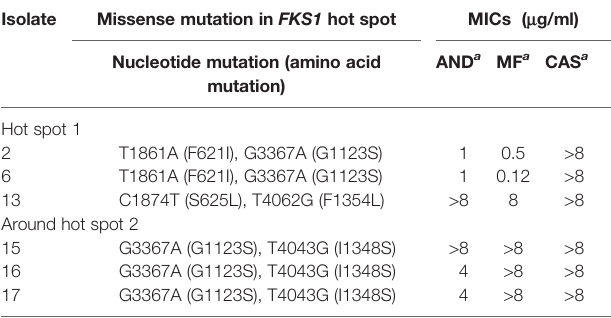
TABLE 5 | The variability of FKS1 gene in the hot spot 1 and near hot spot 2 regions in clinical D. catenulata isolates.